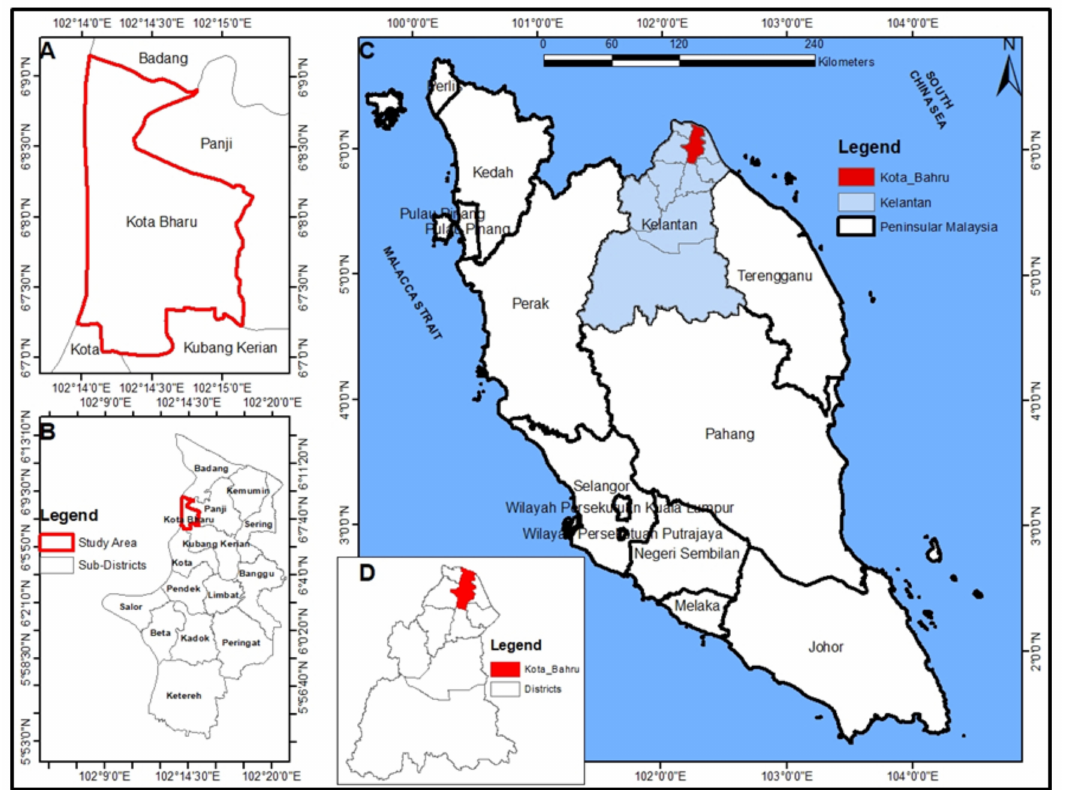
Figure 1. Location of the study area: ( A ) Kota Bharu city, ( B ) Kota Bharu District, ( C ) Peninsular Malaysia, and ( D ) Kelantan